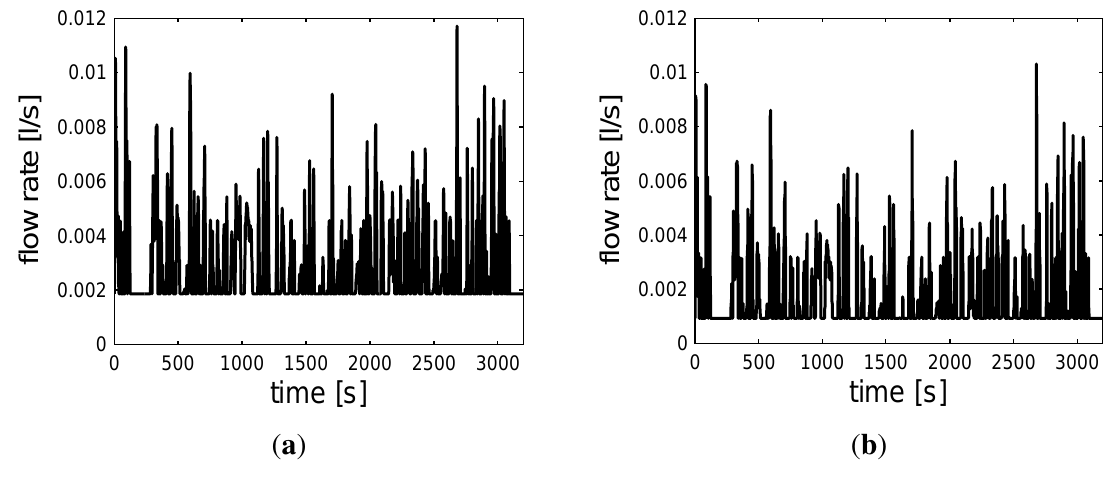
Figure 10. Fuel flow rate of the TV powertrain with the AC turned ( a ) on and ( b )